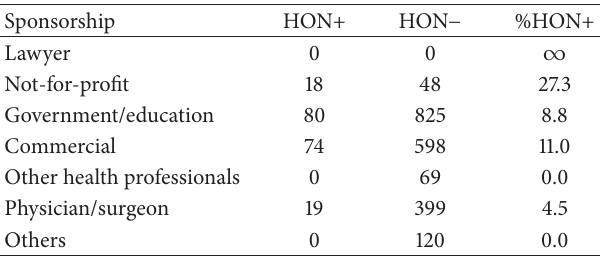
Table 3: Rates of sponsorship and HON-accredited websites within each